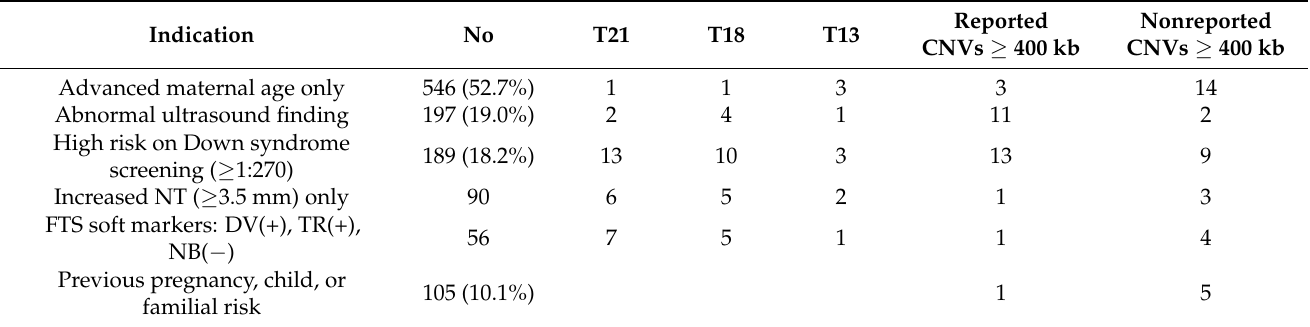
Figure 1. Flowchart of patient G-banding karyotype and chromosomal microarray analysis. CMA: chromosomal microarray (CMA); CNVs: copy number variants; VOUS: variant of uncertain significance. Table 1. Major indications for prenatal chromosomal microarray analysis (CMA) for 1037 pregnancies with aberrant findings.